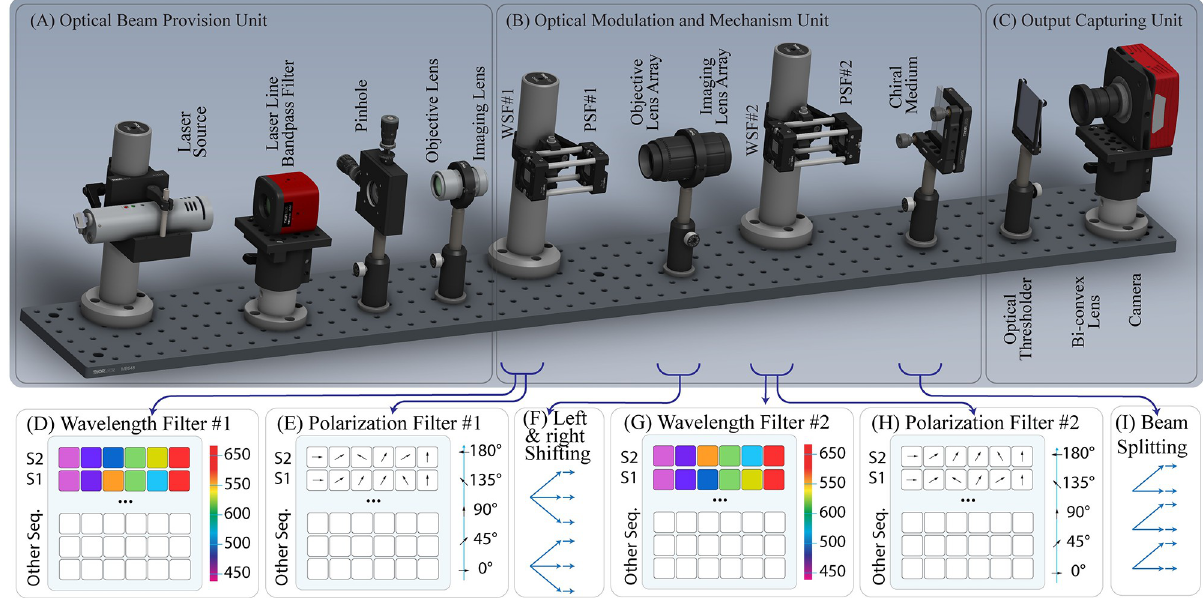
Fig 6. Schematic illustration of the HELIOS optical architecture. (A) The optical beam provision unit provides a collimated beam to feed the whole system. In this manner, the wideband laser beam, produced by a laser source, passes through the laser line bandpass filter and the pinhole to be cleaned. Afterward, the clean beam is diverged and collimated with passing through the objective and imaging lenses, respectively. Finally, the collimated beam is directed to the optical modulation and mechanism unit. (B) In the optical modulation and mechanism unit, passing collimated beam through WSF #1 modulates the wavelength of the optical beam based on the self-label coding of S 2 and S 1 on the first and second rows of a 2 × N pixels image, respectively; while PSF #1 performs their polarization selection based on their nearby-label coding scheme. Afterward, the objective and imaging lens arrays diverge and recollimate the optical beam through a horizontal direction to perform the shifting process of the alignment procedure. Moreover, WSF #2 and PSF #2 code S 1 and S 2 on the first and second rows of a 2 × N pixels image, respectively. By passing the expanded beams through WSF #2 and PSF #2, the proposed architecture compares the shifted coded S 2 with S 1 at the first row, implementing the S 1 -align operation, and compares the shifted coded S 1 with S 2 at the second row, implementing the S 2 -align operation. Finally, each pixel is directed to two distinct pixels via a chiral medium to compensate for false mismatches. (C) Finally, in the output capturing unit, optical thresholdder eliminates wavelength cross-talks and speckle noises of the output before capturing. Afterward, the output is captured by a bi-convex lens and a charged-coupled device (CCD)